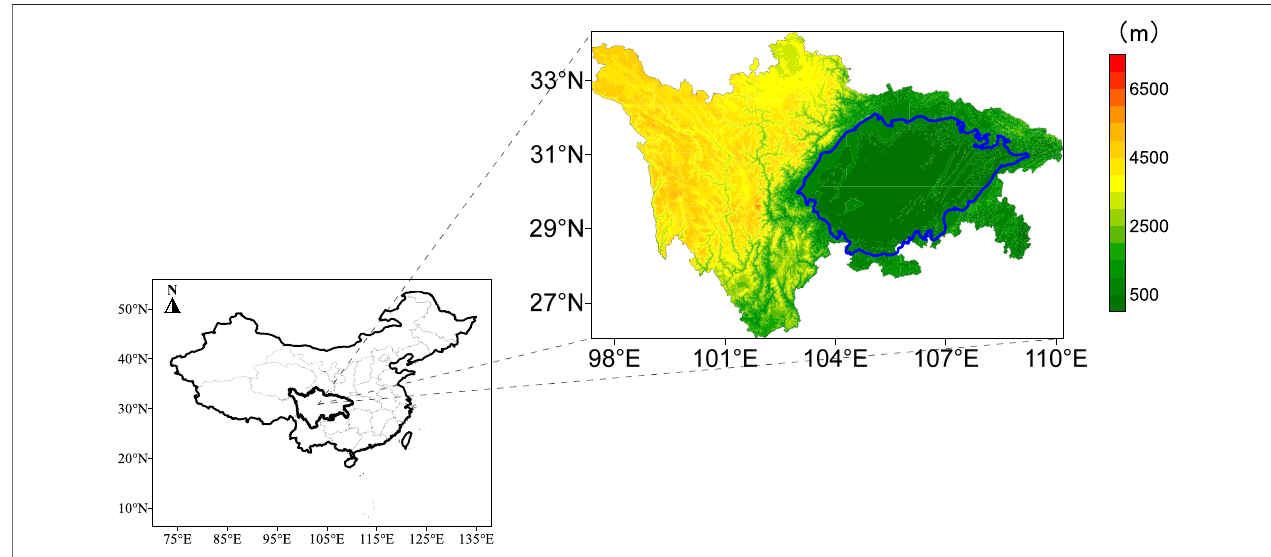
FIGURE 1 | Geographical location of the Sichuan – Chongqing area in China and its elevation (m). The area surrounded by the blue border is the Sichuan basin.